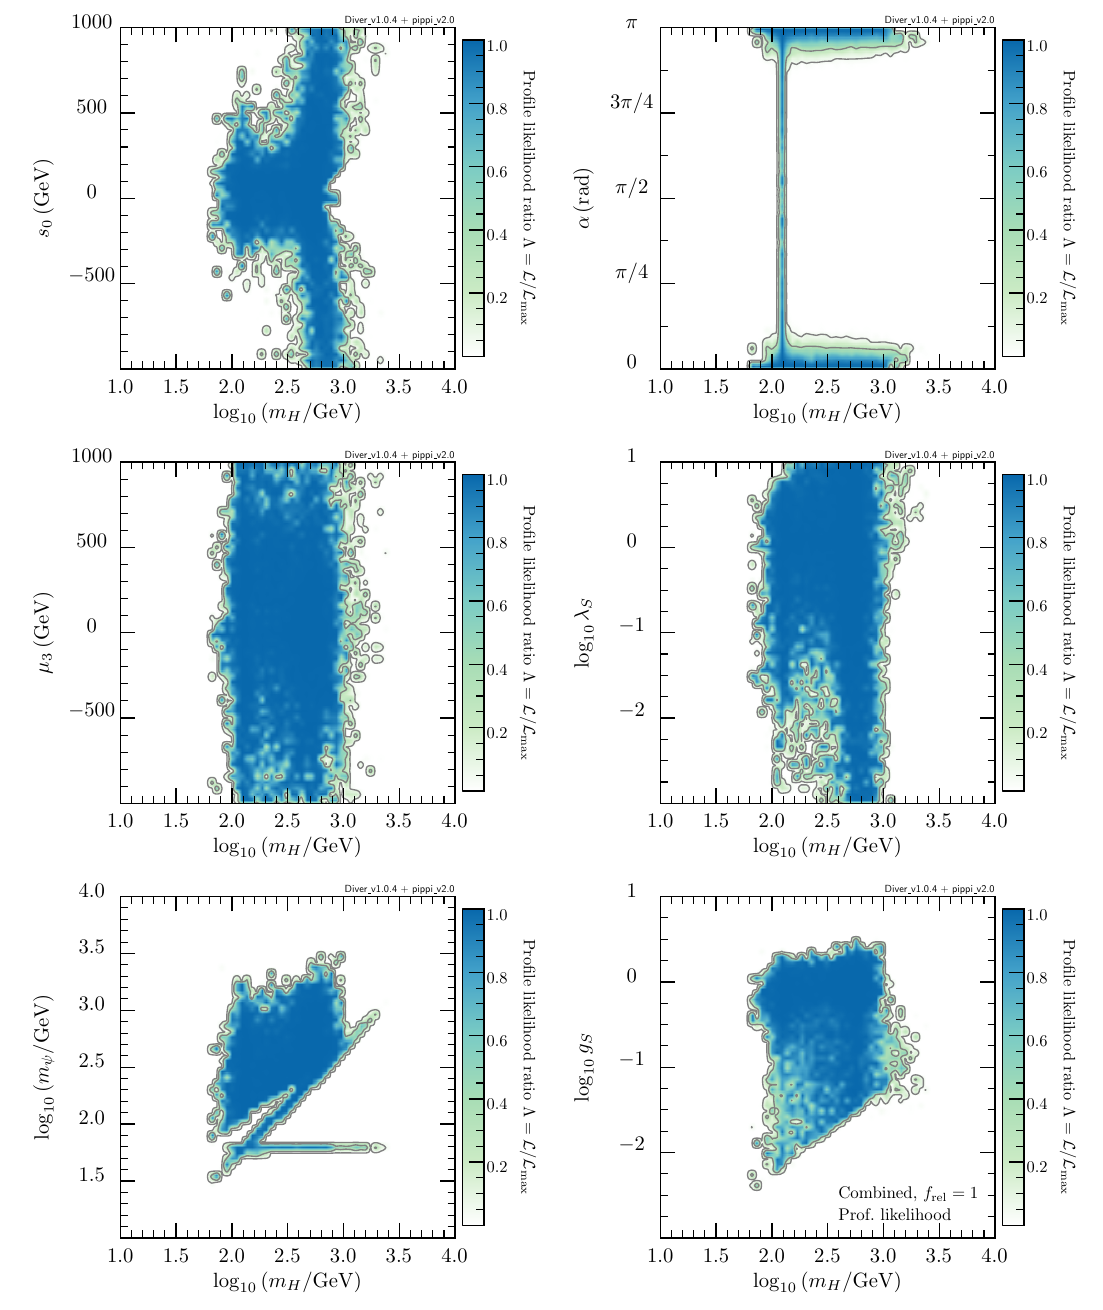
Figure 8 . Same as (cid:12)gure 4 except for the f